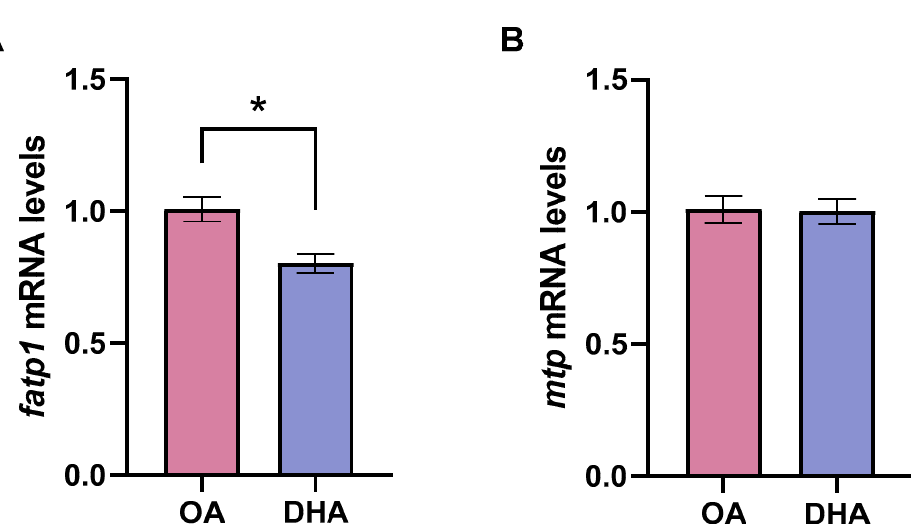
Figure 2. Transcript levels of fatty acid transport protein 1 ( fatp1 ) ( A ) and microsomal triglyceride transfer protein ( mtp ) ( B ) in mature adipocytes incubated for 6 days with 100 µ M oleic acid (OA) or 100 µ M docosahexaenoic acid (DHA). Samples ( n = 8) were analyzed with real-time qPCR; data are presented as fold change ± SEM using ef1 α as a reference gene and the OA group was set to one (delta-delta method). Asterisks (*) indicate significant di ff erences between conditions ( p < 0.05; Student’s t -test). Table 1. Fatty acid composition (% of total) in mature Atlantic salmon adipocytes. Di ff erentiated cells at day 9 were incubated with oleic (OA) or docosahexaenoic acid (DHA) for 6 days (mean ± SEM; n = 3). OA